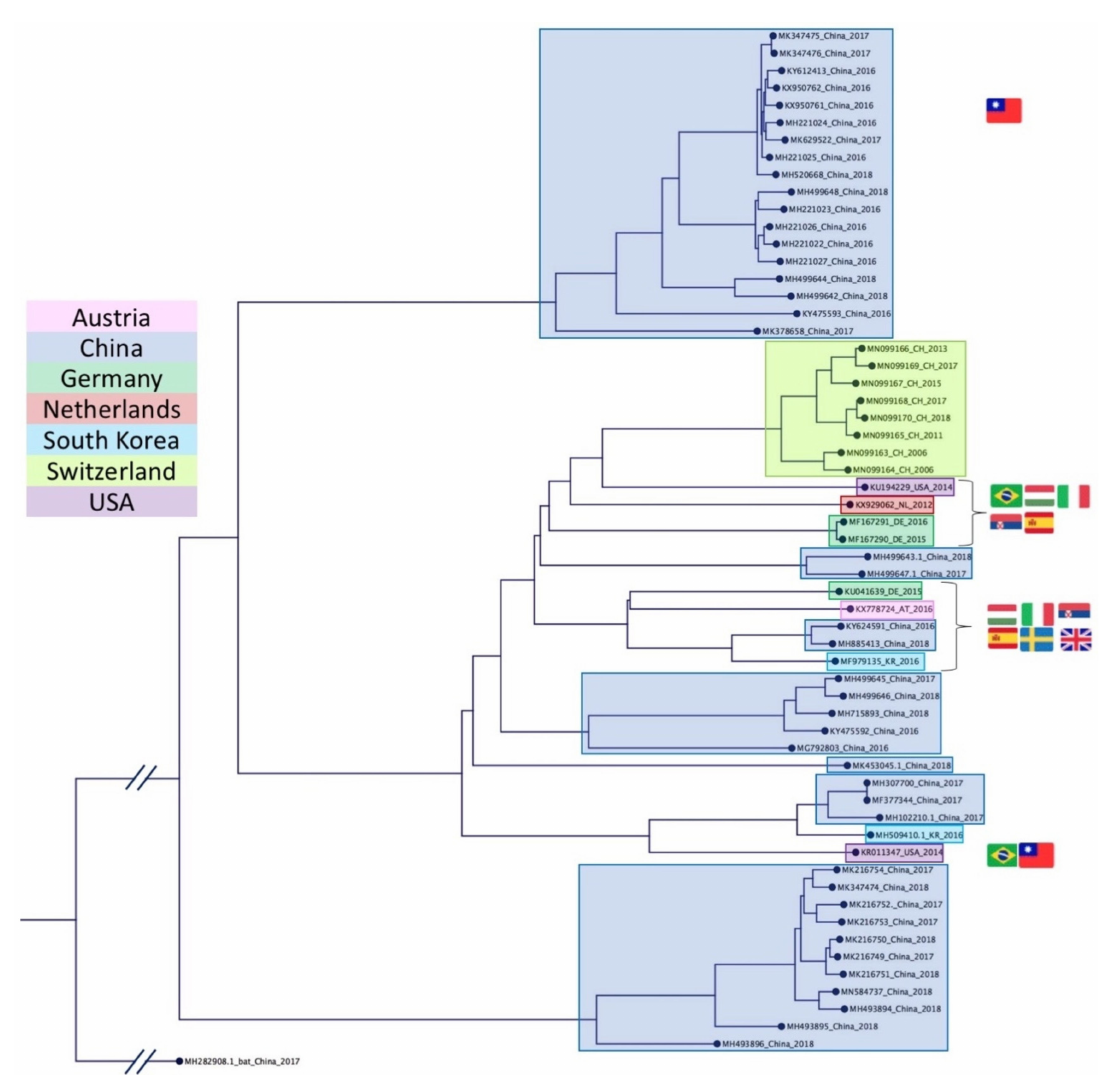
Figure 3. Neighbour Joining tree of full ORF coding sequences of APPV isolates available from GenBank. The tree was generated from 1000 replicates and a bat pestivirus isolate from China has been used as an outgroup (MH282908). GenBank accession numbers as well as the year of isolation are given for each isolate in the tree. Isolates are coloured according to geographic origin. Flags indicate the closest related full ORF sequence in case no full ORF coding sequences are available from a country where APPV has been reported. The phylogenetic tree was generated with CLC Sequence Viewer and the multiple sequence alignment with